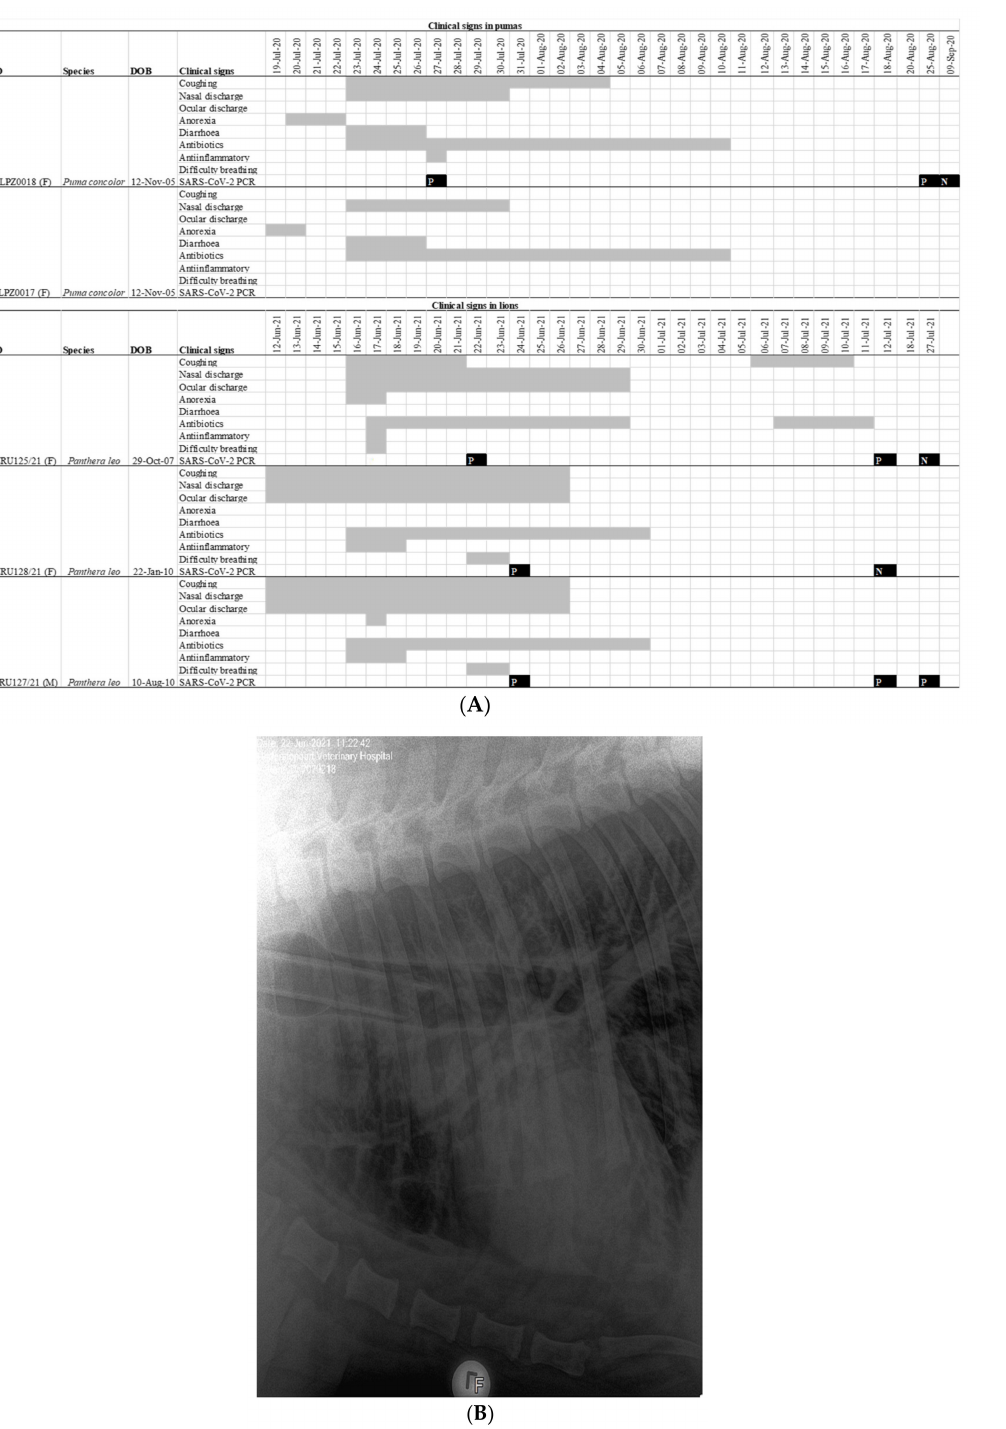
Figure 1. ( A ): Clinical features and timeline of SARS-CoV-2 infection in the pumas and lions. Grey